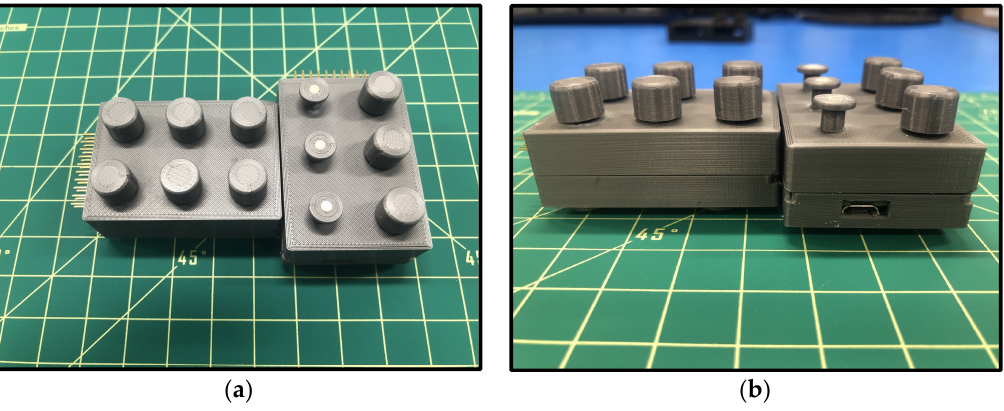
Figure 19. Finalized wire management system on smaller board enclosures. ( a ) Top view of enclosure, ( b ) side view of enclosure, note opening on the side for the charging port.